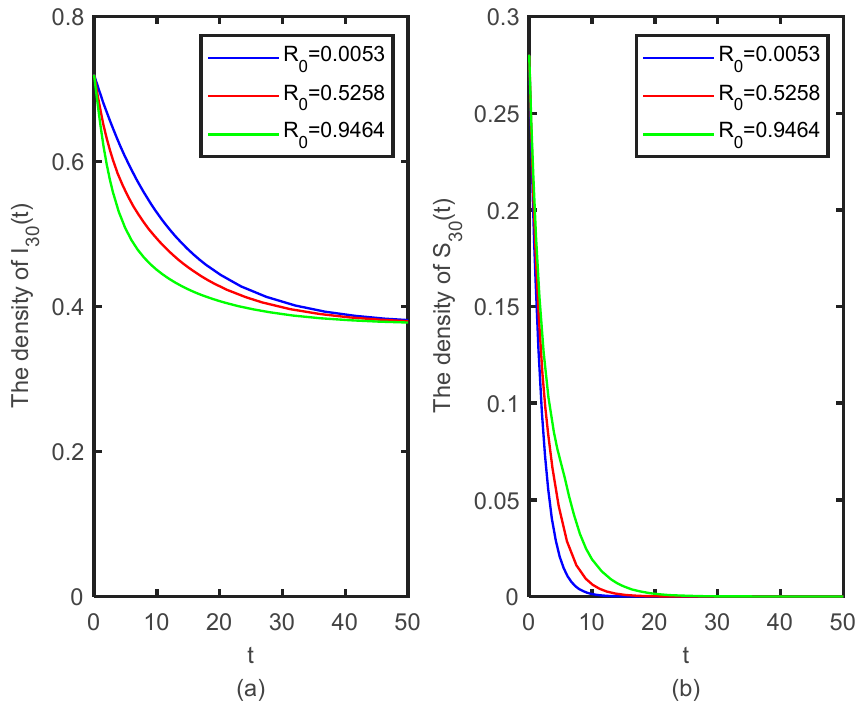
Figure 3. The densities of I 30 ( t ) ( a ), S 30 ( t ) ( b ), considering the variance of R 0 when R 0 < 1.